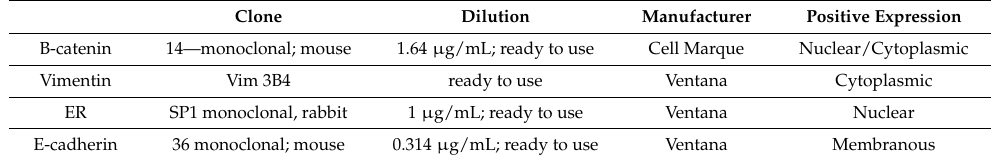
Table 1. The antibodies’